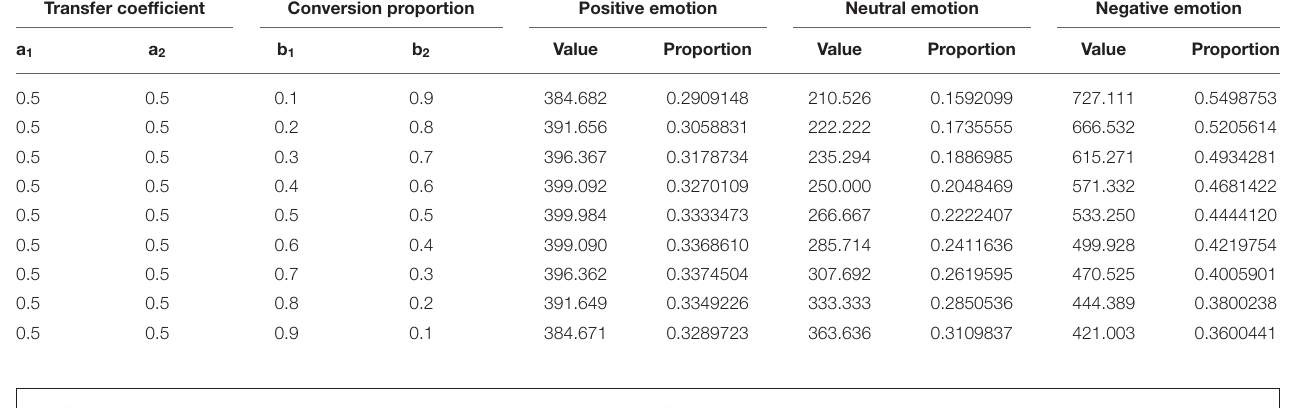
TABLE 4 | Simulation results under the condition of controlling the transfer coefficient.